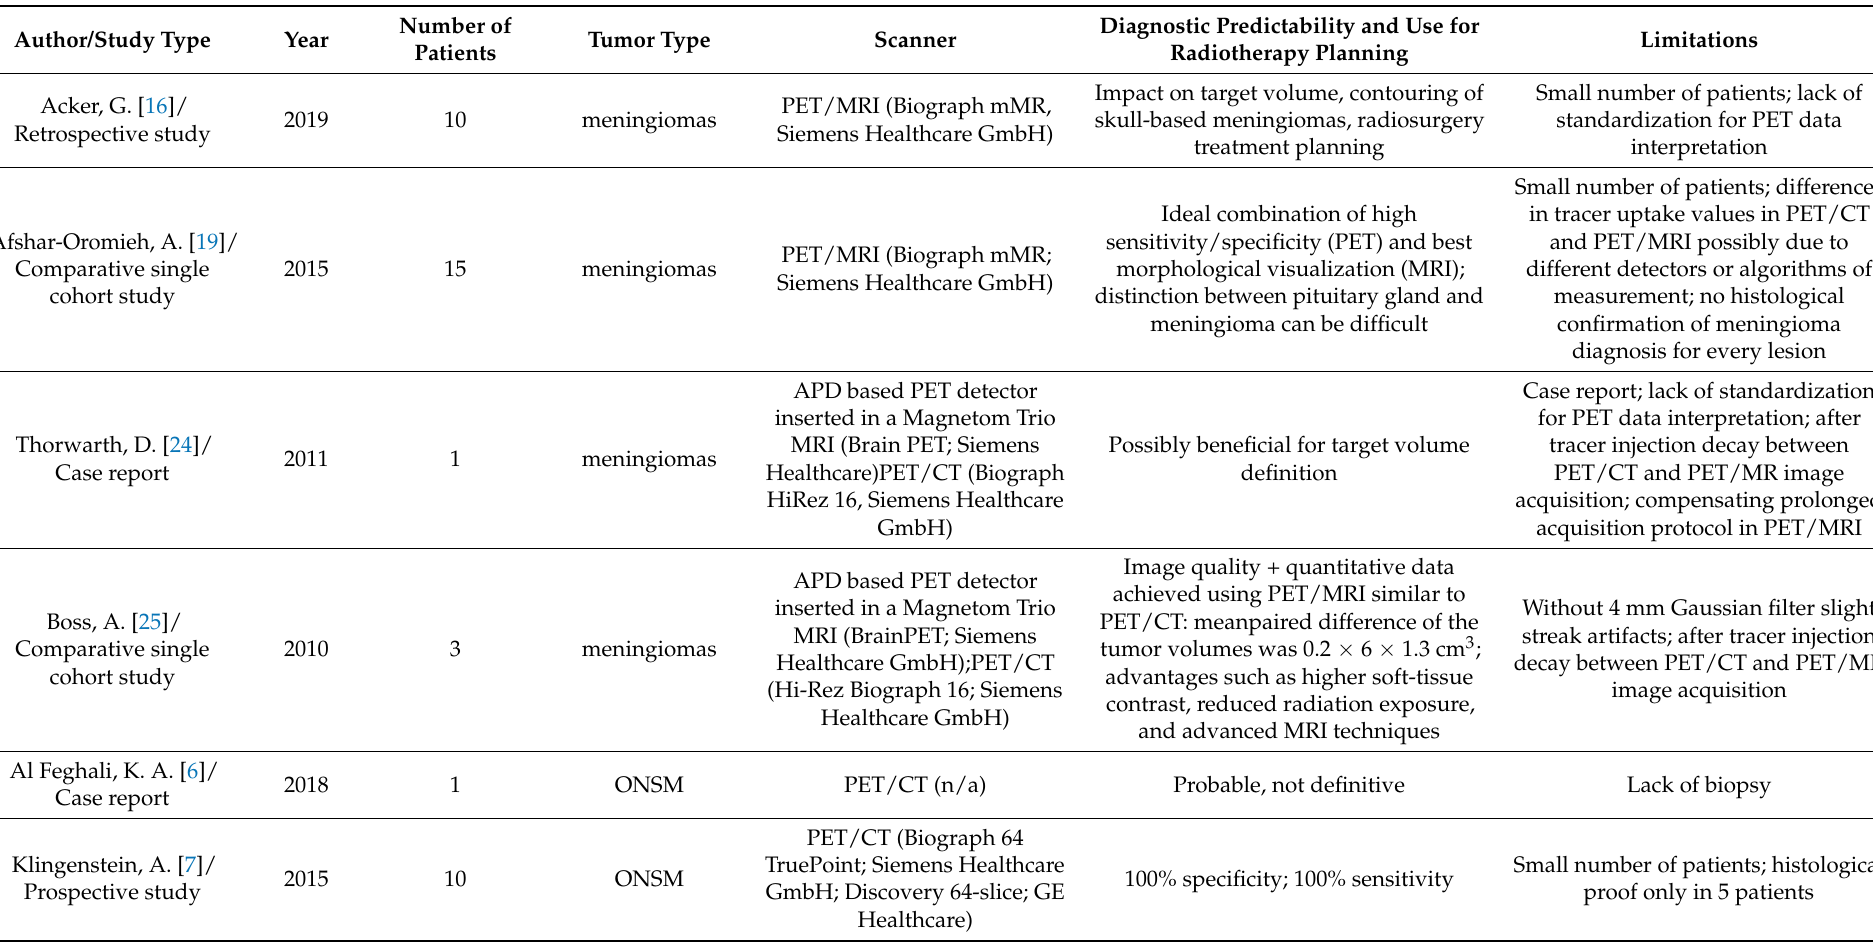
Table 2. Literature review results regarding somatostatin receptor-based PET/MRI in meningiomas and PET/CT in